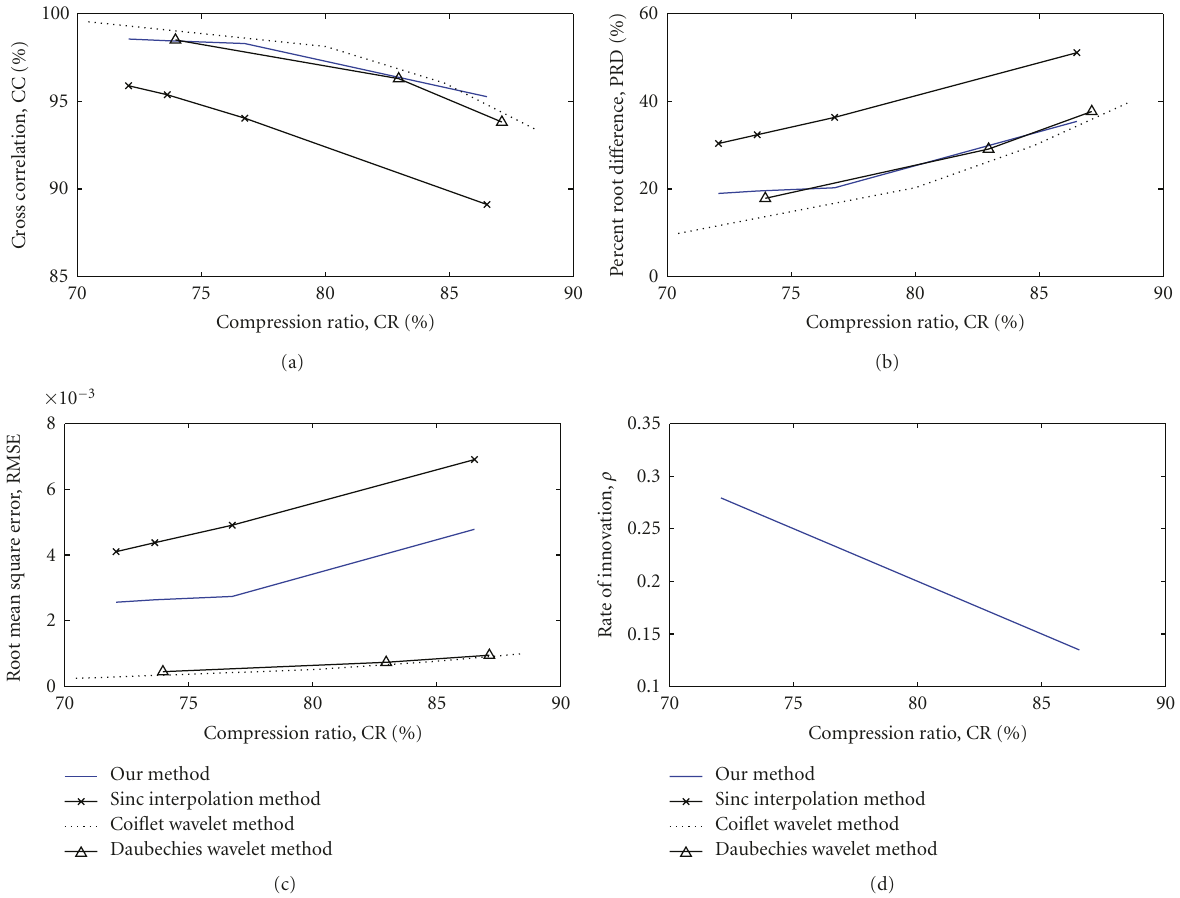
Figure 12: A comparison of the performance of our method with sinc interpolation, wavelet compression using Daubechies and coiflets wavelets on an EEG epoch. (a) Variation of CC with CR. (b) Variation of PRD with CR . (c) Variation of RMSE with CR . (d) Variation of ρ with CR